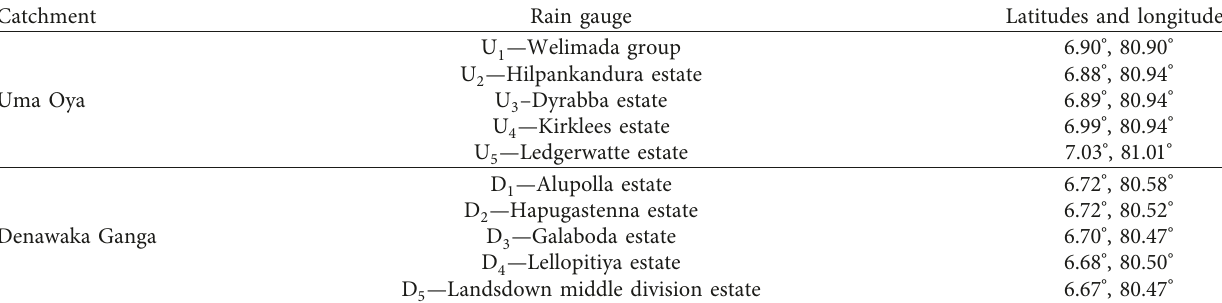
Table 1: Selected rain gauges in two